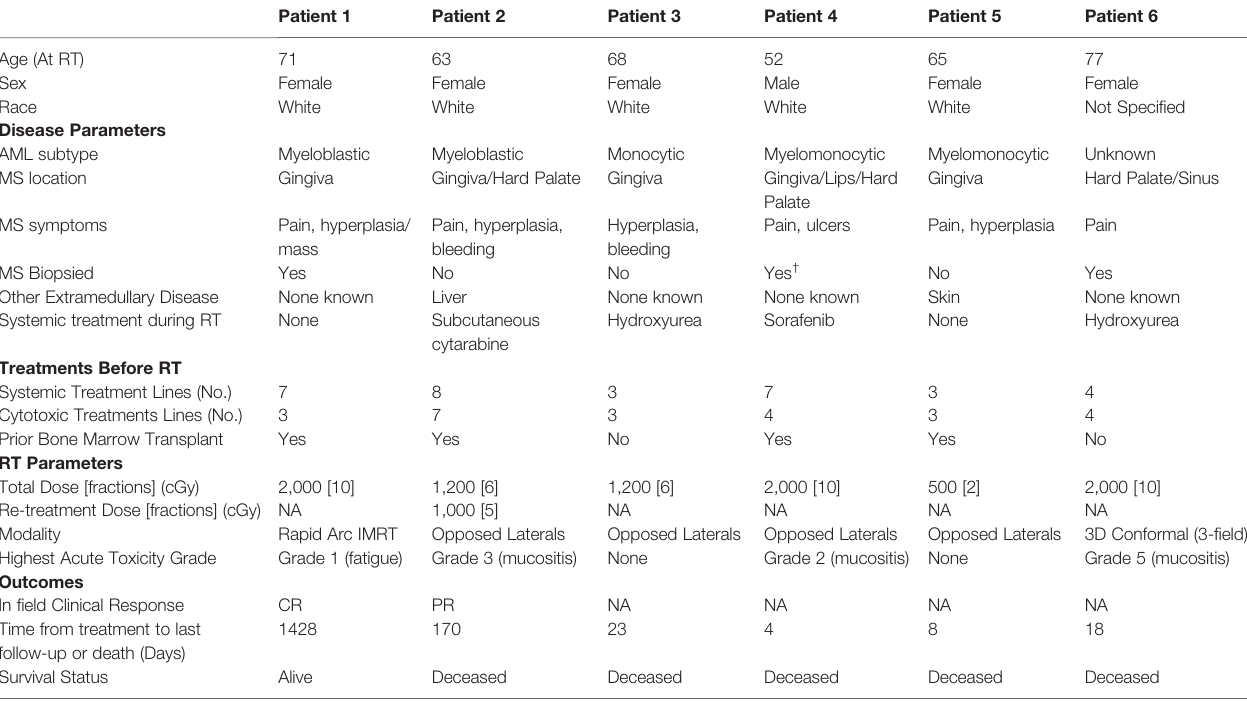
TABLE 1 | Demographics, Clinical Characteristics, Treatment Parameters, and